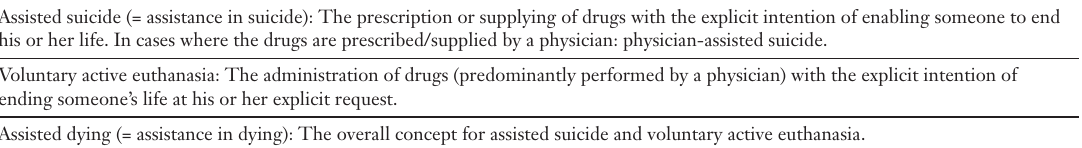
Table 1 Terms and definitions as used in this